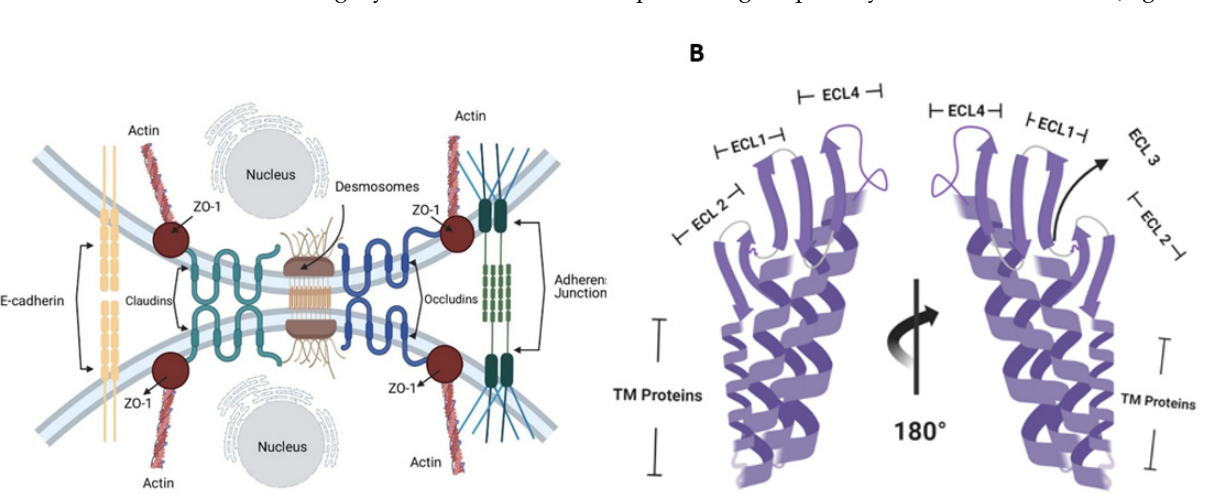
Figure 1. ( A ) Claudin receptors are a major component of tight junctions, preventing the entrance of molecules into the cells and maintaining cellular permeability and osmotic potential. ( B ) Structural domains of Claudin-4.